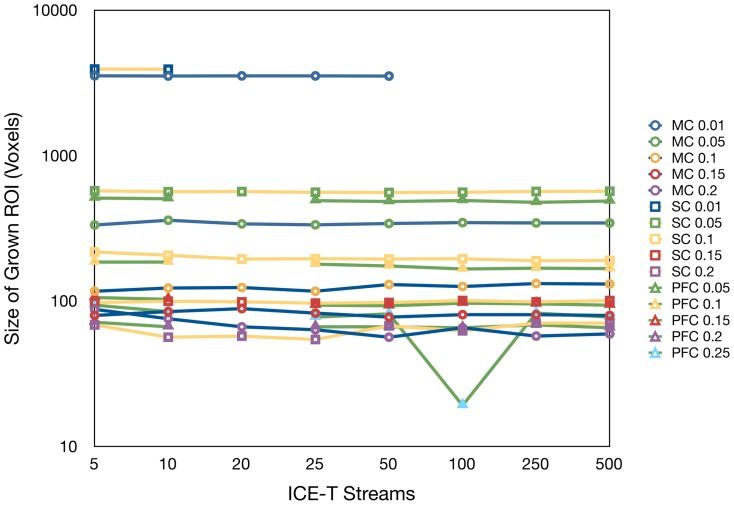
The impact of the ICE-Tstreams parameter.Curves show the parameter's effect upon the size of ICE-T_ROII for various choices of the ICE-Tthreshold parameter and seed regions (detailed in the legend). Seed regions are labelled as MC (motor cortex), SC (somatosensory cortex) or PFC (prefrontal cortex).